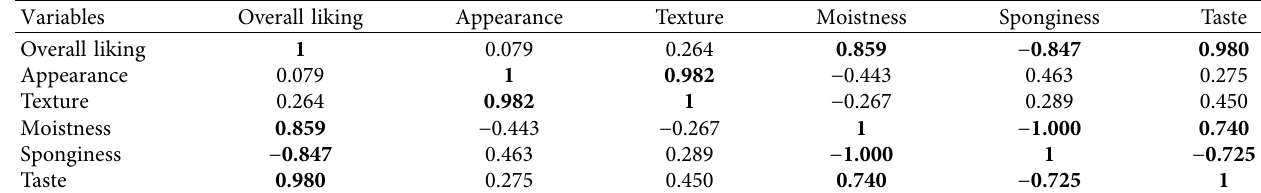
Table 4: Correlations 1 between muffin